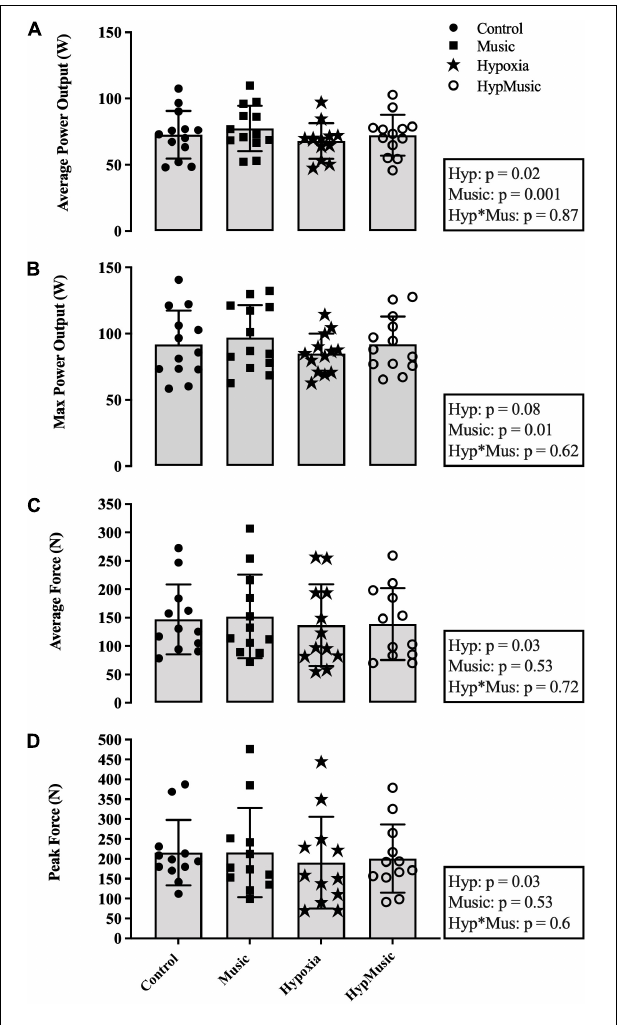
FIGURE 2 | (A) Average power output (W). (B) Maximum power output (W). (C) Maximal voluntary contraction [average force over 60-s (N)]. (D) Peak force (N). Main effects and interactions are displayed in the respective boxes where Hyp signifies Hypoxia and Hyp*Mus signifies the Hypoxia × Music Interaction.